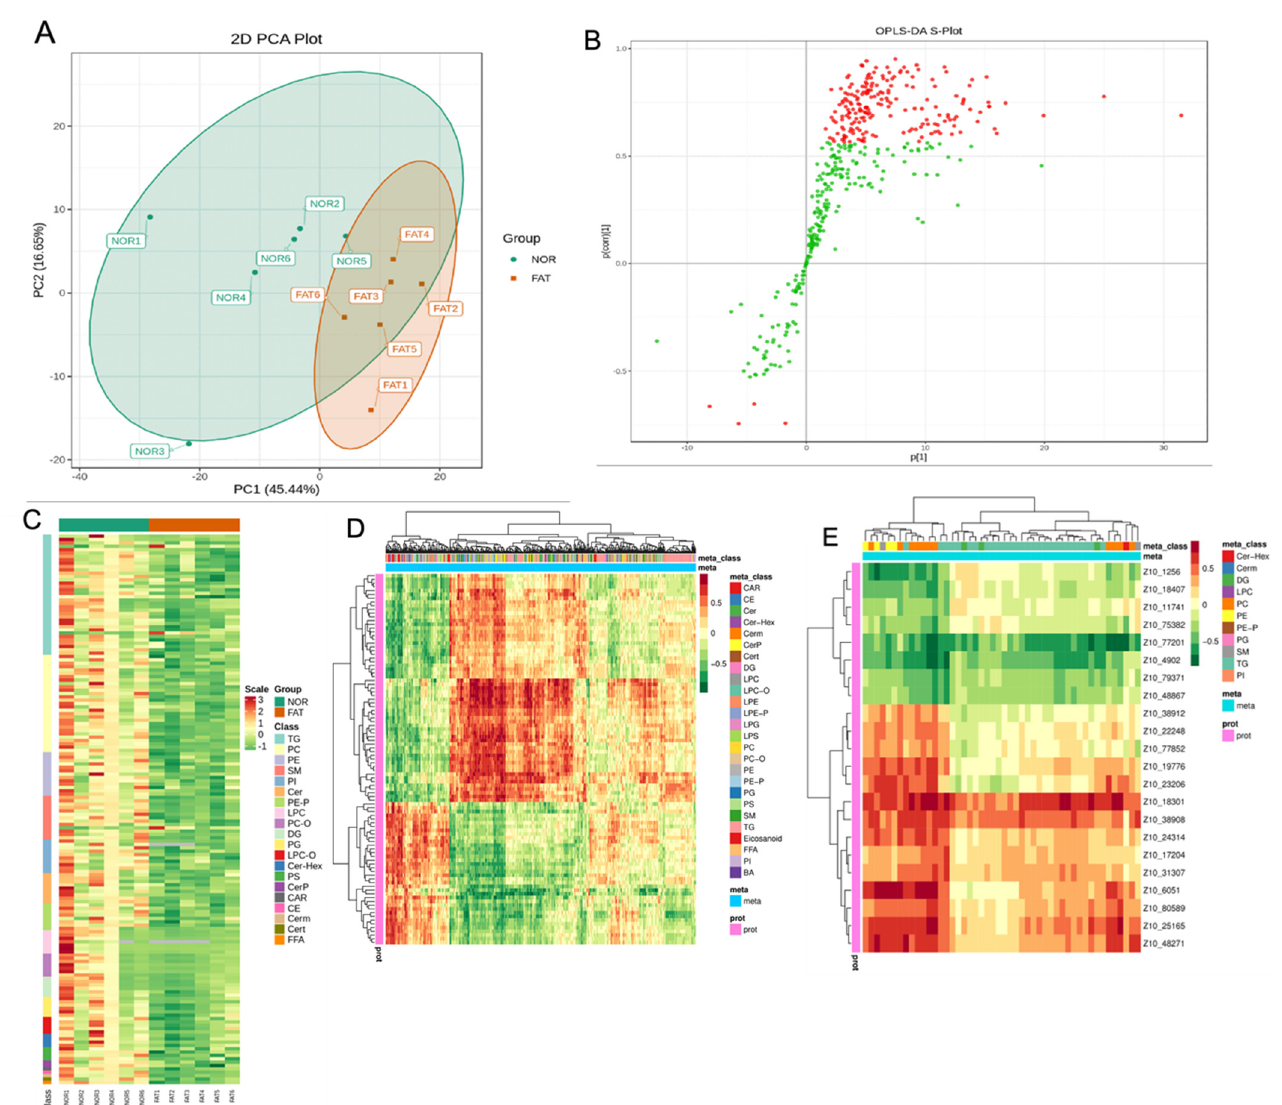
Figure 4. The lipidomics analysis of largemouth bass liver. ( A ) Principal component analysis (PCA) score plots. ( B ) OPLS-DA analysis (red points and green points represent VIP ≥ 1 and VIP ≤ 1, respectively) and ( C ) heatmap. (Mean ± SEM, n = 8). ( D ) Heatmap of all lipids and proteins (red represents high correlation coefficient; green represents low correlation coefficient). ( E ) Heatmap of correlation coefficient of differential lipids and differential proteins (red represents a positive correlation between proteins and lipids and green represents a negative correlation). Each row and column represents a protein and a metabolite,